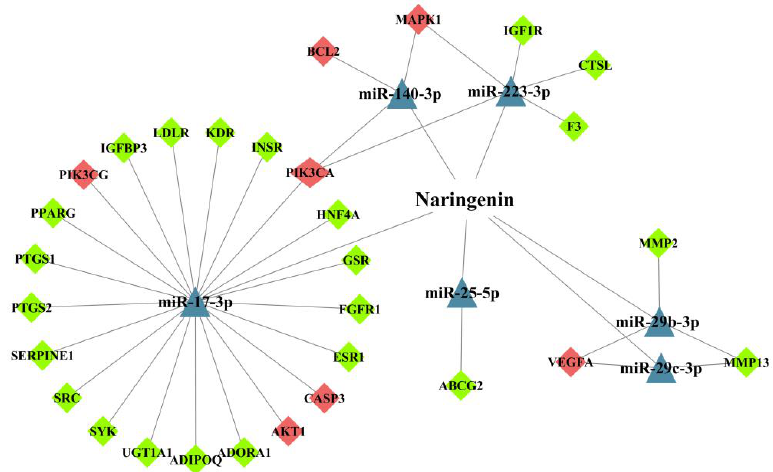
Figure 6. The network for microRNAs (miRNAs)-mediated targets of naringenin in the treatment of COPD. The triangles represent miRNAs and diamonds represent target genes. Red diamonds represent targets that may be relevant to COPD pathogenesis.